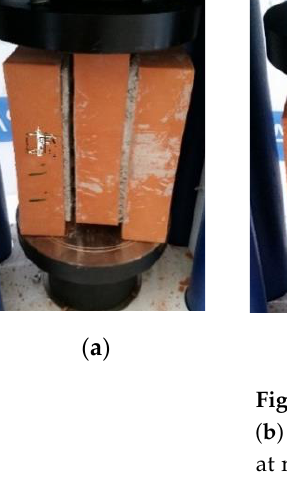
Figure 4. Typical failure modes observed during the shear triplet tests: ( a ) sliding a long bed joint, ( b ) diagonal shear cracking at mortar and crashing at the bottom of right, ( c ) diagonal shear crack